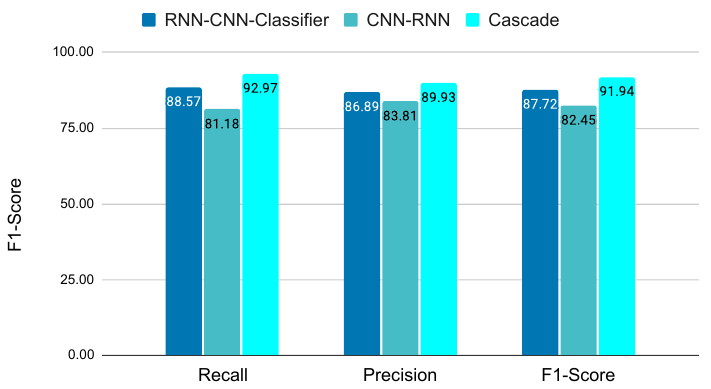
Figure 15. Average F1-Score exhibited by the three different hybrid models. Results from the specialized models. ( left ) Scalar variables are processed by the RNN-based model , then the images are process by the CNN-based model , and finally, a third classification model is used to produce the final prediction. (middle) CNN-based model is used to extract the main features from the images, then they are concatenated with the scalar variables, and the final input sample is processed by the RNN-based model to obtain the final prediction. ( right ) RNN-CNN cascade model .